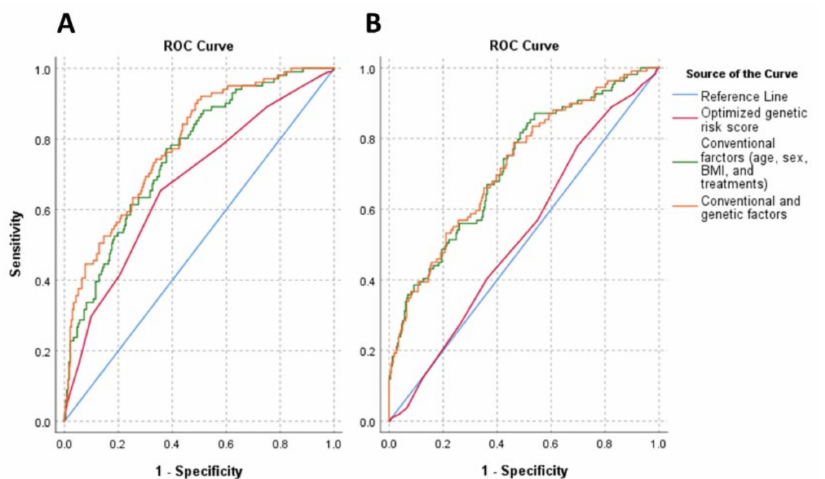
Figure 4. Receiver operating characteristic (ROC) curves and AUC for discriminating insulin resis- tance (HOMA—IR > 3.63). Graphs show ROC curves and AUC for conventional risk factors (age, sex, BMI, and treatments) by the green line, optimized genetic risk score by the red line, and combinations of these by the orange line for the Roma ( A ) and Hungarian general ( B ) populations. The reference was marked by a light blue line, indicating zero predictive value of the model. Conventional risk factors: AUC Roma : 0.756, AUC HG : 0.722; optimized genetic risk score: AUC Roma : 0.673, AUC HG : 0.528; combinations of conventional risk factors and optimized genetic risk score: AUC Roma : 0.785, AUC HG : 0.723.